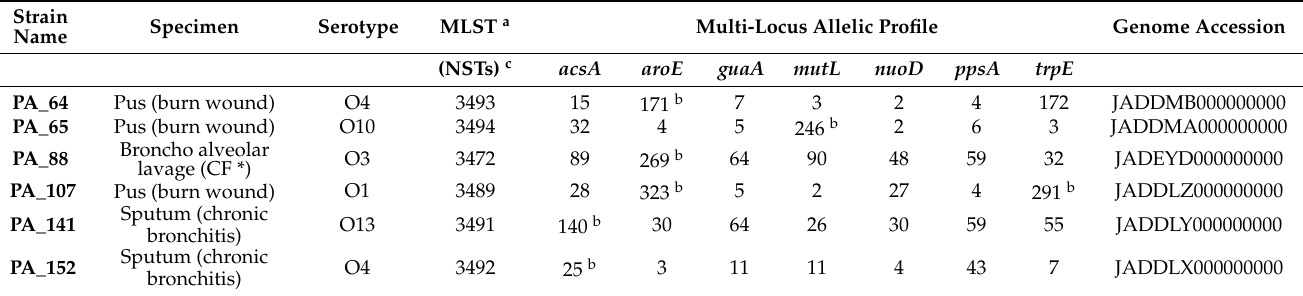
Table 3. Allelic profiles, assigned sequence types (ST), and NCBI accession numbers of six Pseudomonas aeruginosa clini- cal